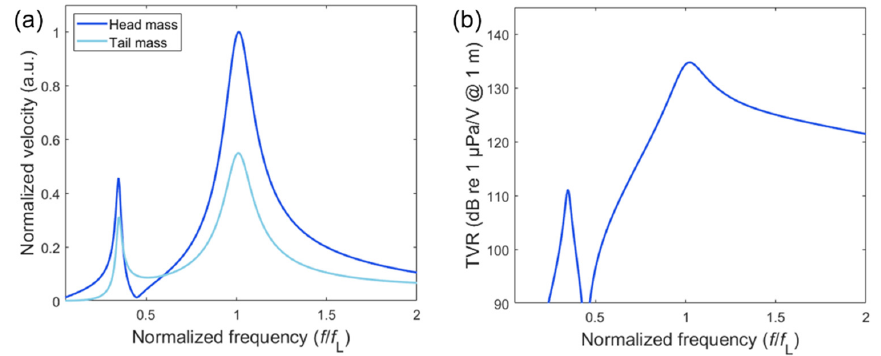
Figure 9. The comparison between the ( a ) velocity spectra (head mass and tail mass) and ( b ) TVR spectrum calculated by the distributed circuit model (basic design).